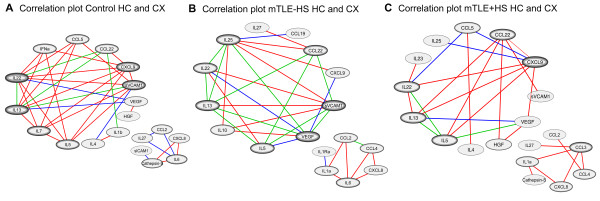
Correlation network plots for all patient groups. Network plots depicting significant correlations between levels of inflammatory mediators in Control patients (A), mTLE -HS patients (B) and mTLE + HS patients (C). Line (edge) color indicates in which tissue correlation was found: red = HC, blue = CX, green = HC & CX. Per patient group two main non-overlapping correlation networks were identified. Note that correlation networks are remarkably similar among the patient groups. Inflammatory mediators like IL-5, IL-13 and IL-22 all display >4 correlations with other inflammatory mediators. Only proteins that were in a network of more than 6 correlations (nodes) are depicted. In addition, 5 significant correlations were found in the total data set. In Control HC IL-10 & CCL3 correlated with IL-25 and in mTLE-HS CX Cathepsin-S correlated with ICAM1. All correlations had a correlation coefficient > 0.85 with a Bonferoni corrected p-value < 0.0017